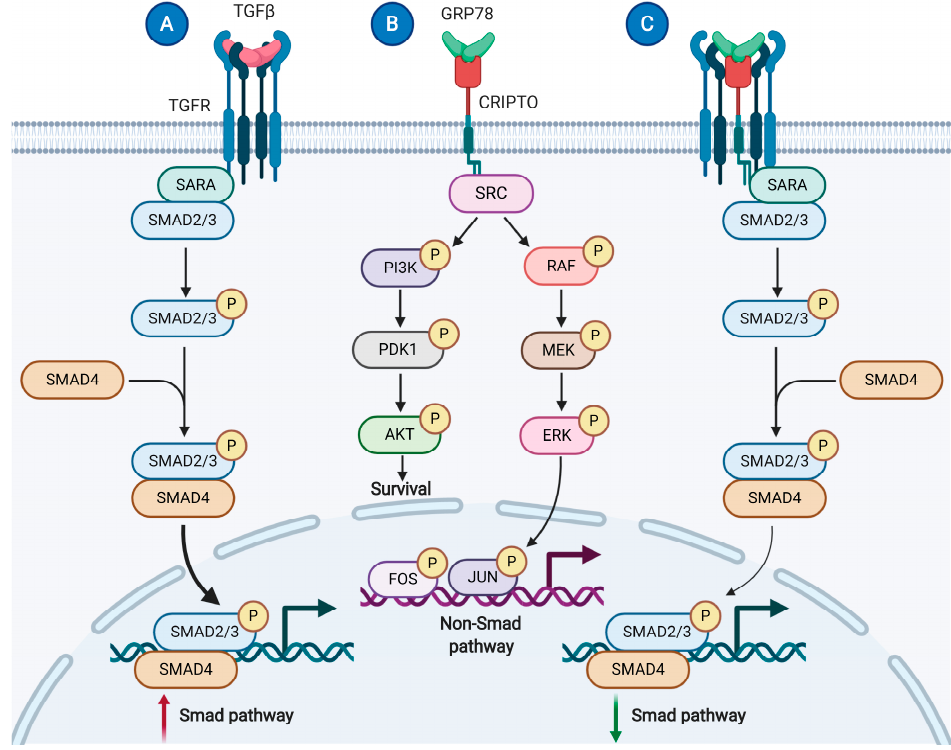
3 Figure 3. Model of extracellular GRP78 and interacting protein, Cripto, modulation of TGF β signaling. ( A ) Transforming growth factor beta (TGF β ) ligand binding to TGF β receptors (TGFR) leads to activation of genes responsive to Smad2 / 3 signaling. ( B ) The 78 kDa glucose regulated protein (GRP78), an ER luminal Ca 2 + -binding chaperone, is secreted upon ER Ca 2 + depletion. Secreted GRP78 is a co-factor required for Cripto-1 growth factor (Cripto) activation. Cripto activates Src, Ras / Raf / MAPK and PI3K / Akt pathways via a mechanism that remains unknown. ( C ) Cell surface Cripto / GRP78 interaction is required for Cripto modulation of TGF β